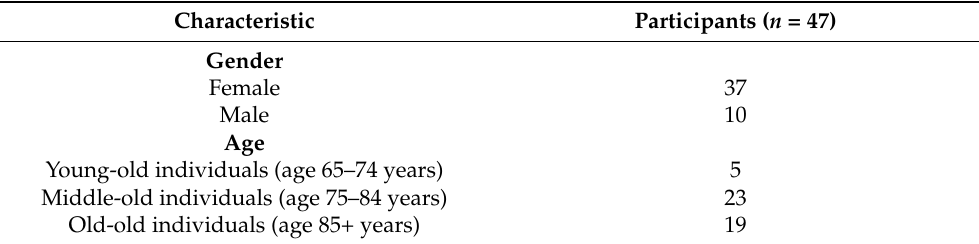
Table 1. Participant